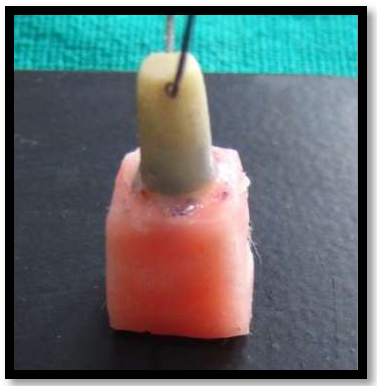
Figure 4. 1 mm hole buccolingually below the incisal edge in coping, 23-gauge wire passing through the hole to provide anchorage.